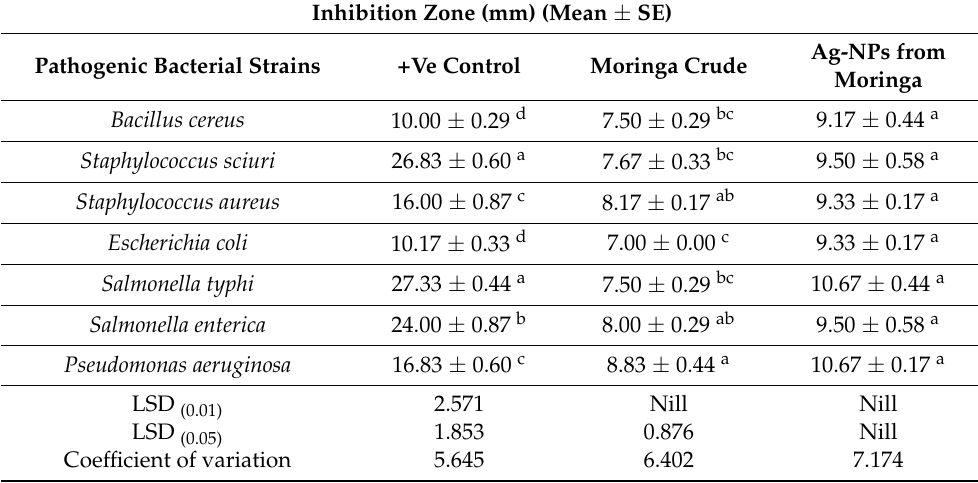
Table 8. Antibacterial activity of Moringa crude aqueous extracts and synthesized Ag-NPs against different bacterial strains by disc diffusion method.